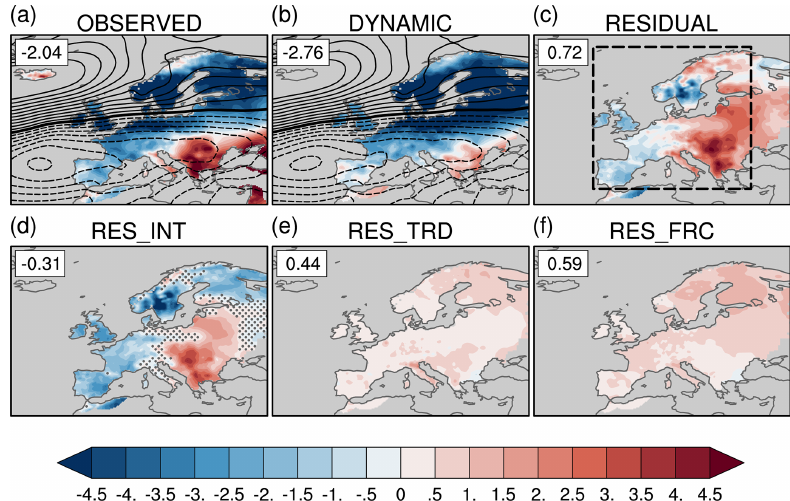
Figure 1. EOBS daily maximum temperature ( ◦ C, shading) and 20CR_V3 sea level pressure (hPa, black line contours with contour interval of 1hPa) anomalies averaged over the European cold spell period (28 December 2009–13 January 2010): (a) total TX anomaly and observed SLP anomaly, (b) TX dynamic component contribution and reconstructed SLP anomaly, (c) TX total residual contribution, (d) TX internal residual contribution, (e) TX long-term trend residual contribution and (f) TX residual contribution from forced changes in other factors. Numbers in the upper right corner indicate the weighted average TX anomaly over the region delimited by the black dashed box in (c) . In (a) and (b) , the black thick contour line indicates the zero SLP anomaly and dashed contour lines indicate negative SLP anomalies. In (d) , stippling indicates grid points where RES INT values are within the uncertainty range of the dynamical component given by the 95% confidence interval estimated by the bootstrap method given in Sect.